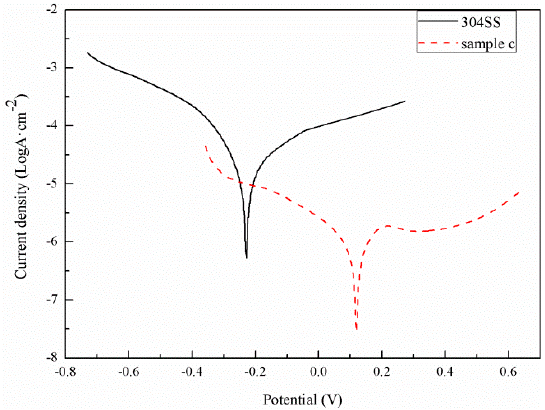
Figure 10. Potentiokinetic curves of the samples simulated in a proton exchange membrane fuel cell (PEMFC) environment.